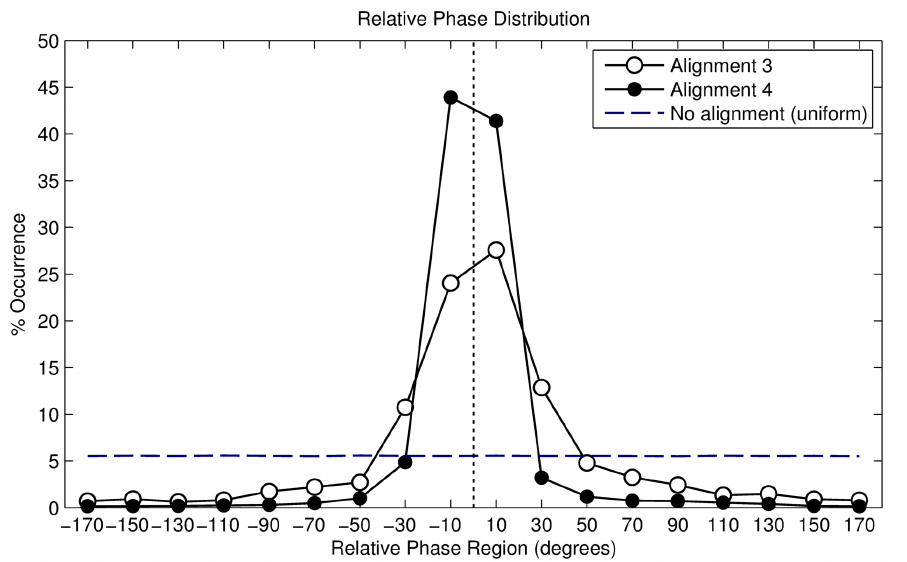
Fig. 12. Angular histogram of alignment strategy 4 (tempo-adaptive